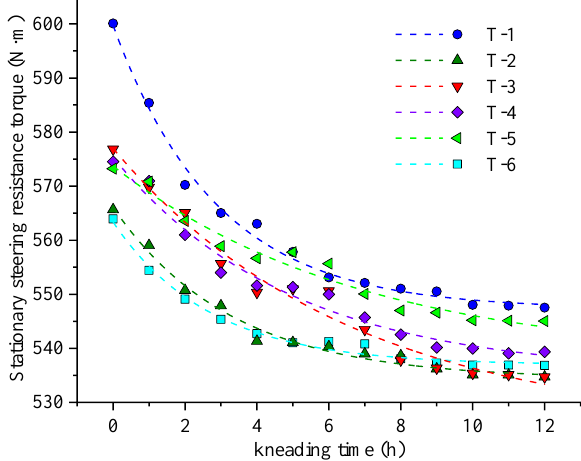
Figure 15. Fitting curve of stationary steering resistance torque. For different combinations of the texture parameters, the initial value, attenuation rate, and final value of the stress concentration factor are different. As shown in Figure 14 and Table 10, the indicator values of each sample decrease rapidly at the initial stage and then gradually tend to stabilize. Based on the value of the parameter B, the attenuation speed of T-1, T-3, T-4, and T-5 is higher than T-2 and T-6, which indicates that the greater the density of the curved groove, the more significant the stress concentration effect and the faster the abrasion of the pavement structure. The initial value order of the stress concentration coefficient is T-1 > T-5 > T-4 > T-3 > T-2 > T-6 and the values of T-1, T-5 and T-4 is similar. The initial values of curved groove interface are approximately in the range of 50 – 60%, while that of the rectangular grooved pavement is only 43%. The initial value of the evaluation indicator of the curved textured pavement is greater than that of the rectangular grooved pavement. Therefore, the meshing friction between the tire and the curved groove is more significant, which can prove that the texture roughness of the ini- tial curved groove is better than that of the rectangular groove. The final values of T-1, T-3, T-4, and T-5 are significantly higher than those of T-2, indicating that the higher the groove density, the better the skid-resistance performance after abrasion. Meanwhile, the attenuation amplitude of T-3, T-4, and T-5 is less than that of T-1, which indicates that the spacing provided between the continuous curved grooves helps disperse the large stress, and the attenuation amplitude of the stress concentration coefficient can be effectively alleviated. Therefore, from the perspective of anti-skid performance, T-4 and T-5 are recommended, and the GGW is 50 ~ 70 mm. As shown in Figure 15 and Table 11, the attenuation rate of the steering resistance torque in the early stage is higher than that in the later stage. The initial values of T-2, T-3, T-4, and T-5 are similar and greater than T-6 but significantly less than that of T-1. This proves that the groove density has a significant effect on the initial steering resistance moment. The greater the texture density, the greater the lateral force acting on the tire. Combined with the analysis of the friction mechanism between the textured pavement and the tire, the groove spacing has an interference effect at the tire – pavement contact interface, which reduces the effect of the lateral torque, yields a moderate initial index value, and reduces the driving shimmy on the curved grooved pavement. The order of final value is T-1 > T-5 > T-4 > T-3 > T-2, and T-6 is slightly higher than those of T-2, T-3, and T-4, which indicates that after abrasion, the appropriate texture parameters can help improve the driving stability of the textured pavement and maintain the steering re- sistance moment at a low level. Therefore, from the perspective of driving stability, T-2, T-3, and T-4 are recommended. Considering the skid resistance performance and driving stability of the pavement, setting certain groove spacing can help effectively reduce the stationary steering re- sistance torque. In combination with the GGW, the skid resistance performance of the